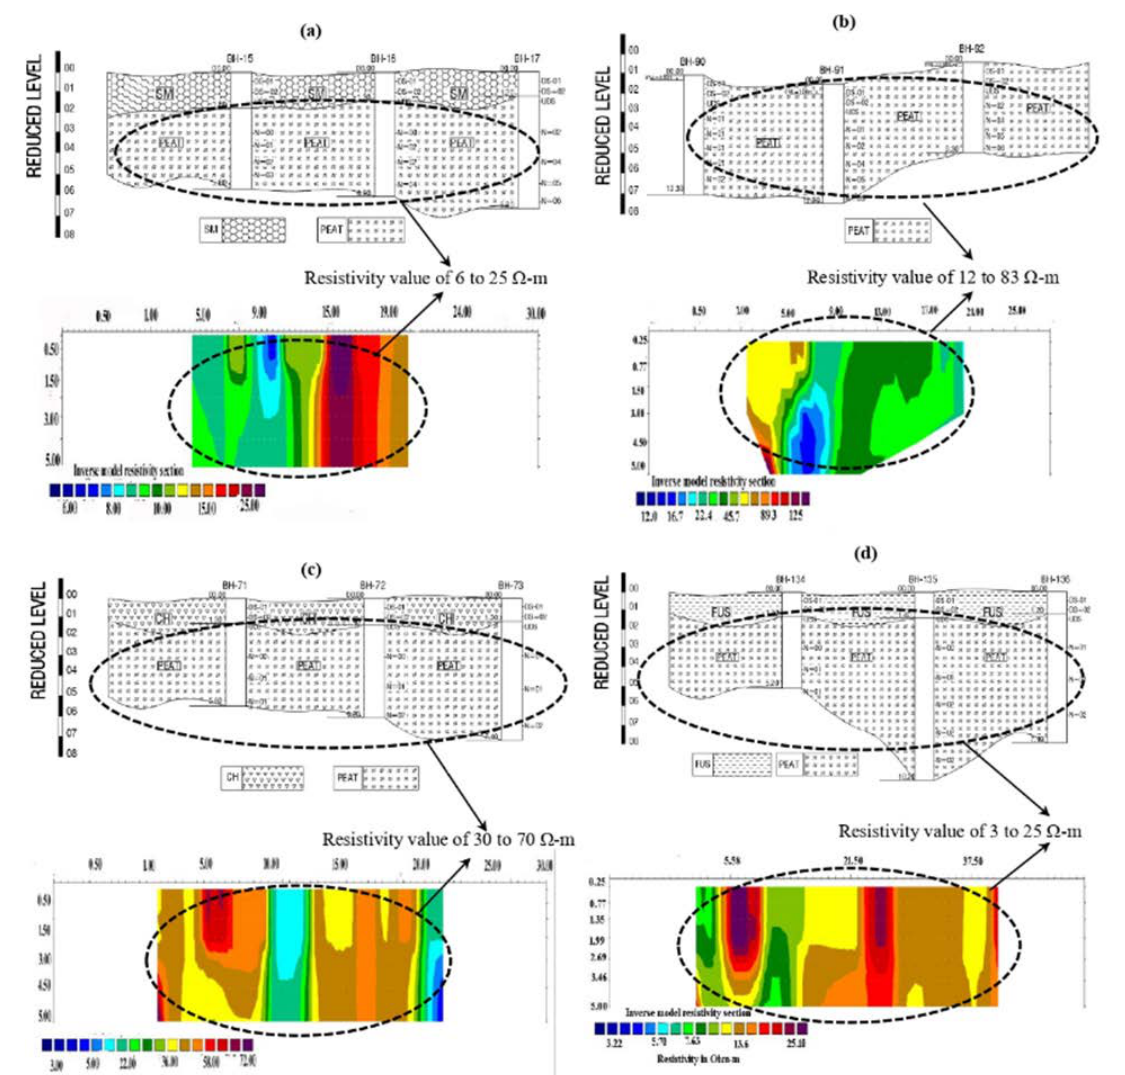
Figure A2. 2D resistivity profile obtained from electric resistivity tests which are validated with subsoil profile for four zones of Agartala town: (a) north zone, (b) east zone, (c) central zone and (d) south